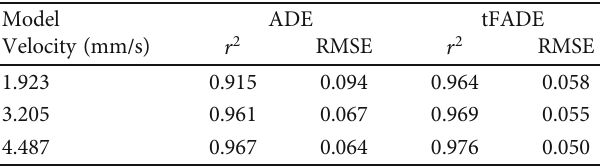
Table 3: Model errors for the BBF transport in the granite fracture with 2.60 mm